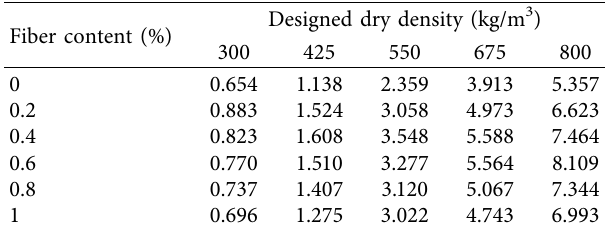
Figure 14: Uneven fiber clusters fall when the sample was scraped. Table 4: Unconfined compressive strength results of cast-in-situ foamed concrete with glass fiber (unit: MPa).